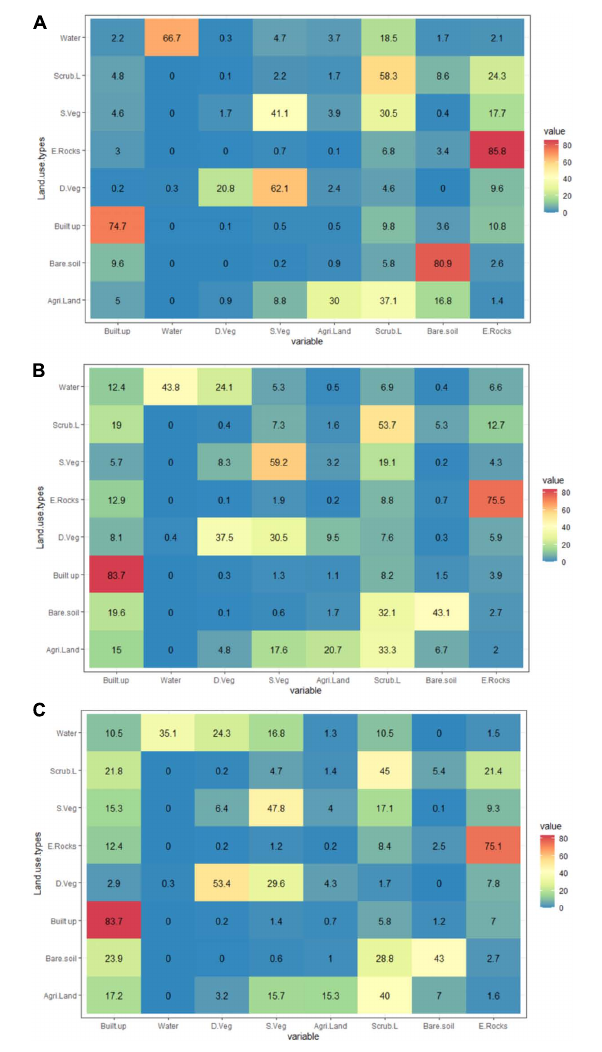
stack multispectral band was 86.4 percent, the overall accuracy for bands 2 (blue), 3 (green), 4 (red), 5 (near-infrared), 6 (shortwave infrared-I), and 7 (shortwave infrared-II) were 85.3 percent, 84.71 percent, 86.63 percent, 85.1 percent, 84 percent, and 84.8 percent. The validation of the LULC map for the year 2000 shows that